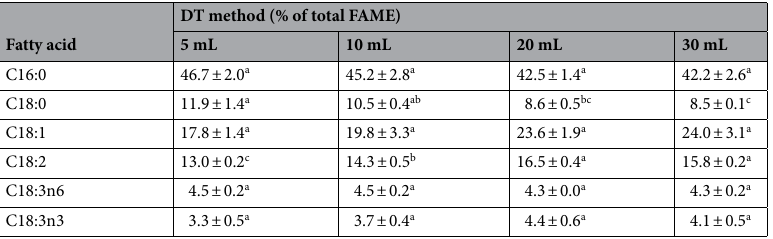
Table 3. Fatty acid composition of C. vulgaris UMT-M1 obtained from direct-transesterification (DT) methods. The values are in mean ± SD (n = 3). Different letters depict significance difference among the group according to one-way ANOVA at p <